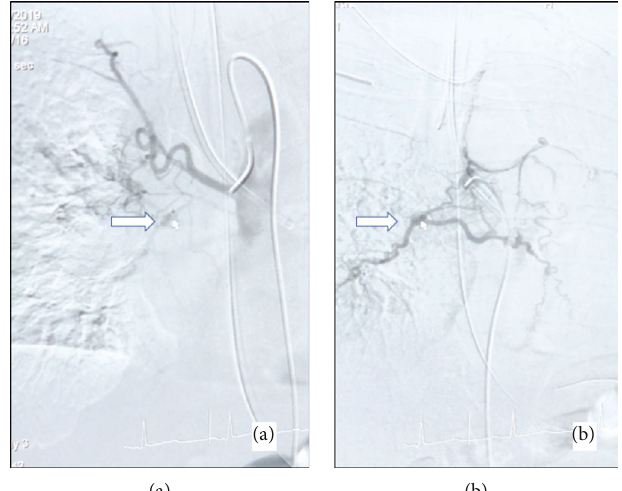
Figure 2: (a) Selective right bronchial artery angiography showed collateral fl ow from the right bronchial artery to the left bronchial artery supplying the presumed bronchial polyp or abnormal blood vessel (white arrow). (b) Selective left bronchial artery angiography showing left arterial supply to the lesion with collateral fl ow from right bronchial artery feeding presumed polyp-like lesion or abnormal vessel (white